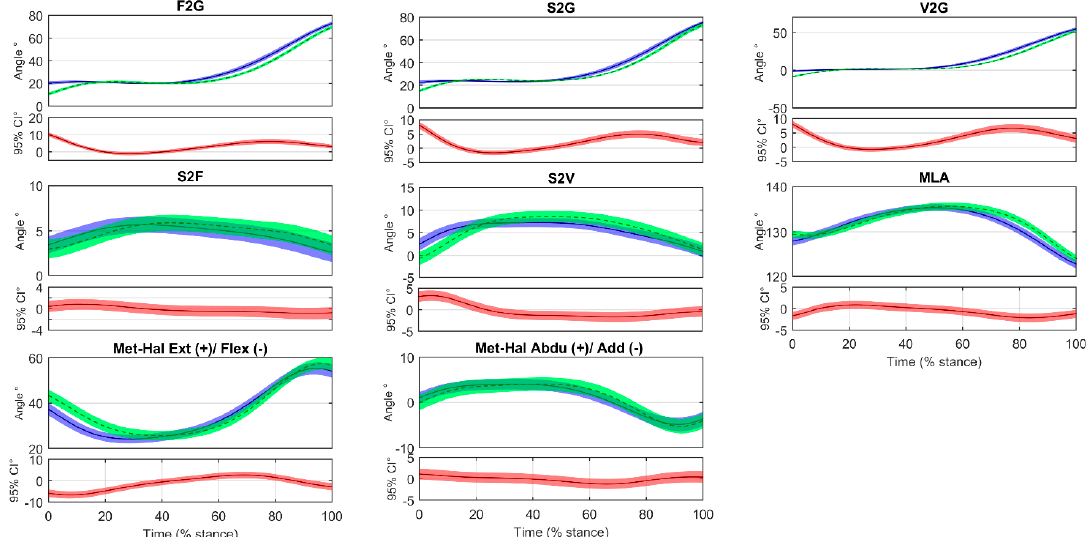
Figure 6. Sagittal-plane inclination of the first metatarsal bone to the ground (F2G), of the second metatarsal bone to the ground (S2G), and of the fifth metatarsal bone to the ground (V2G); transverse-plane divergence between first and second metatarsal bones (S2F) and between fifth and second metatarsal bones (S2V); and first metatarsus and hallux angle (Met-Hal). Time was normalized across stance phase (0–100%) for forefoot strike (FFS) and rearfoot strike (RFS) patterns. Mean ± standard error (SE) bands are reported (shaded regions). Below of each angle plot, there is a between footstrike pattern di ff erence plot (FFS–RFS) containing the mean ± 95% confidence interval (CI) bands (in red). Regions where those bands diverge from zero can be considered regions of significant di ff erences. (Legend: FFS in blue, RFS in